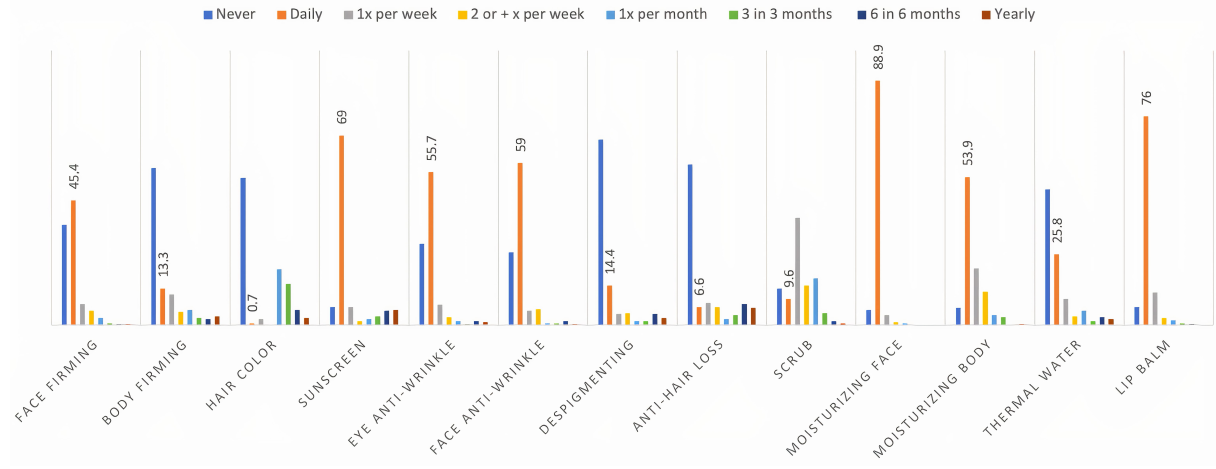
Fig. 1. Type and frequency of use (%) of cosmetic products by female participants.